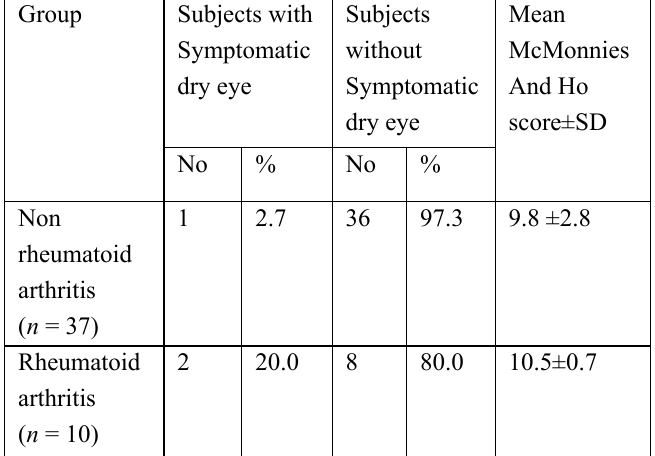
Table 4: Symptomatic dry eye in different arthritic groups